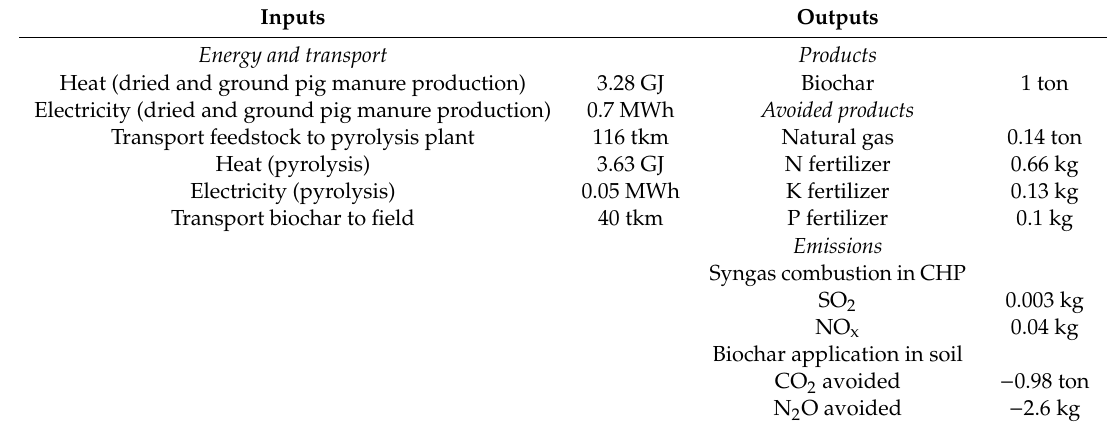
Table 2. The inventory data for 1 ton of biochar obtained via pig manure